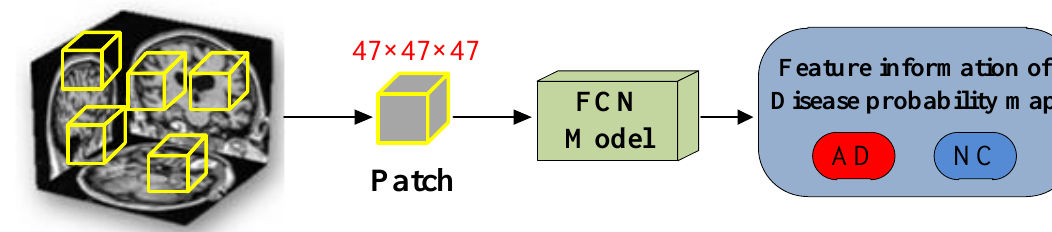
Figure 6. The FCN model’s framework.